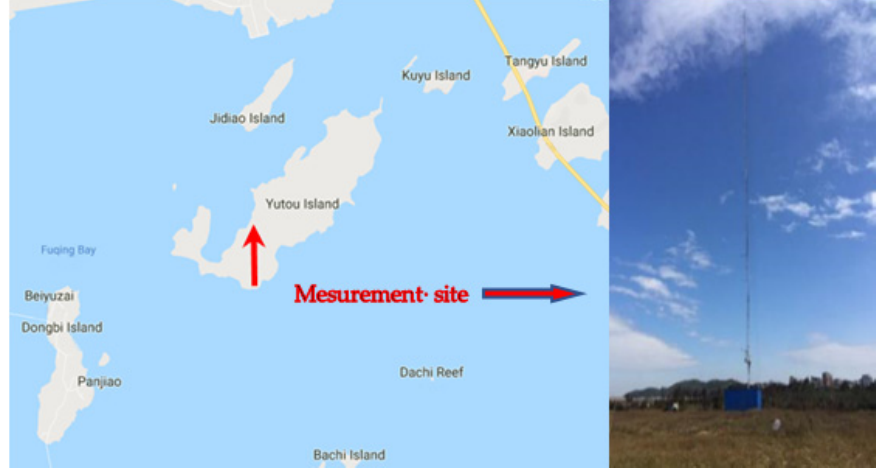
Figure 1. Location of stations on Yutou Island.